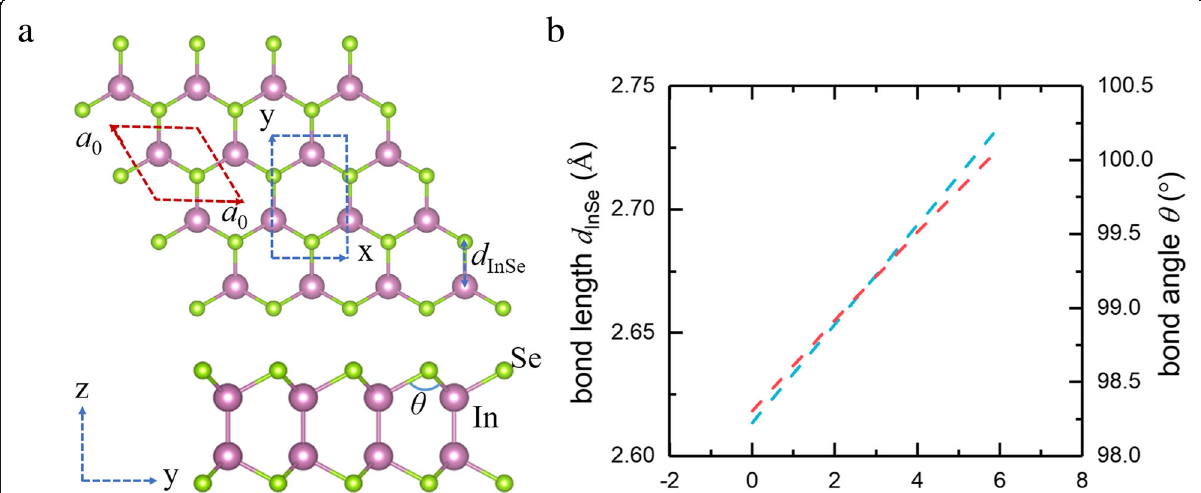
Fig. 1 a Top view and side view of monolayer InSe. Pink and green balls represent In and Se atoms, respectively. b The variation of bond length and bond angle with the increase of biaxial tensile strain. The basic a 0 × a 0 unit cell and x × y supercell of InSe monolayer are denoted with red and blue dashed lines, respectively